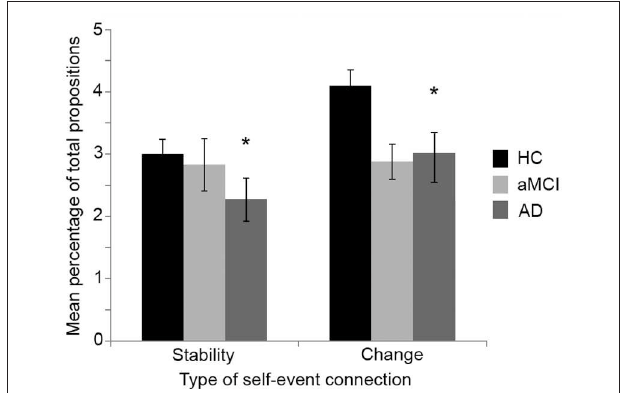
FIGURE 4 | Mean number of self-event connections in the life stories as a percentage of the total number of propositions for each group. HC, Healthy control; aMCI, amnestic Mild Cognitive Impairment; AD, Alzheimer’s disease. Error bars denote one standard error of the mean. *AD group significantly lower than HC